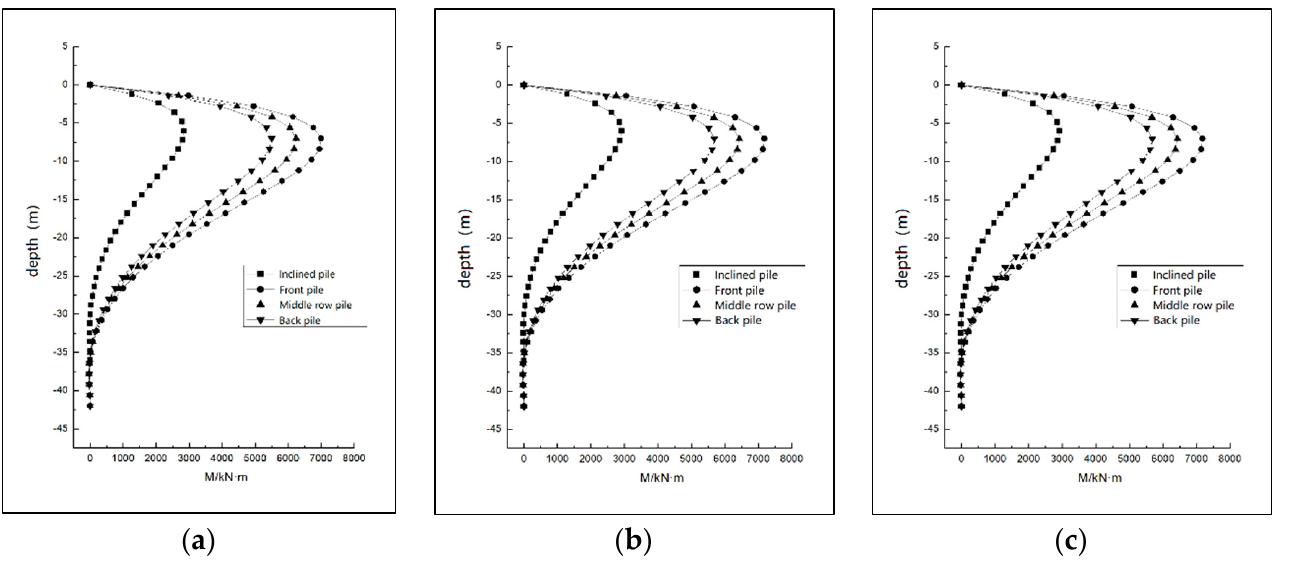
Figure 13. Pile bending moment behavior: ( a ) first column; ( b ) second column; ( c ) third column.